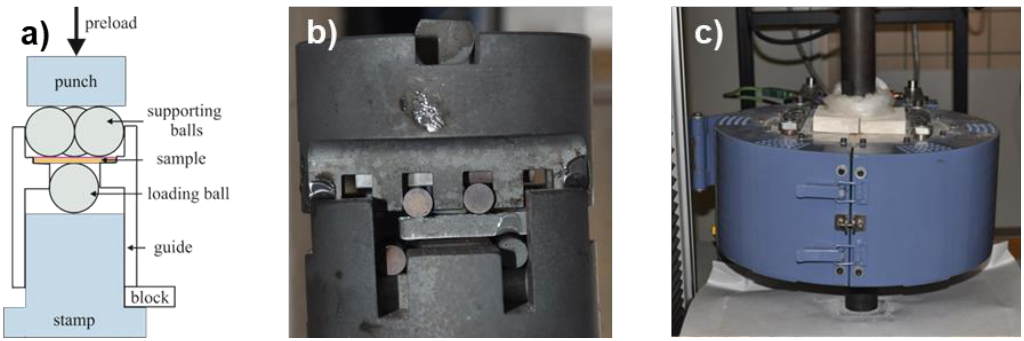
Figure 1. ( a ) Schematic of the ball-on-three-balls (B3B) testing jig; ( b ) molybdenum four-point bend (4PB) test jig; and ( c ) split furnace used for high-temperature B3B and 4PB